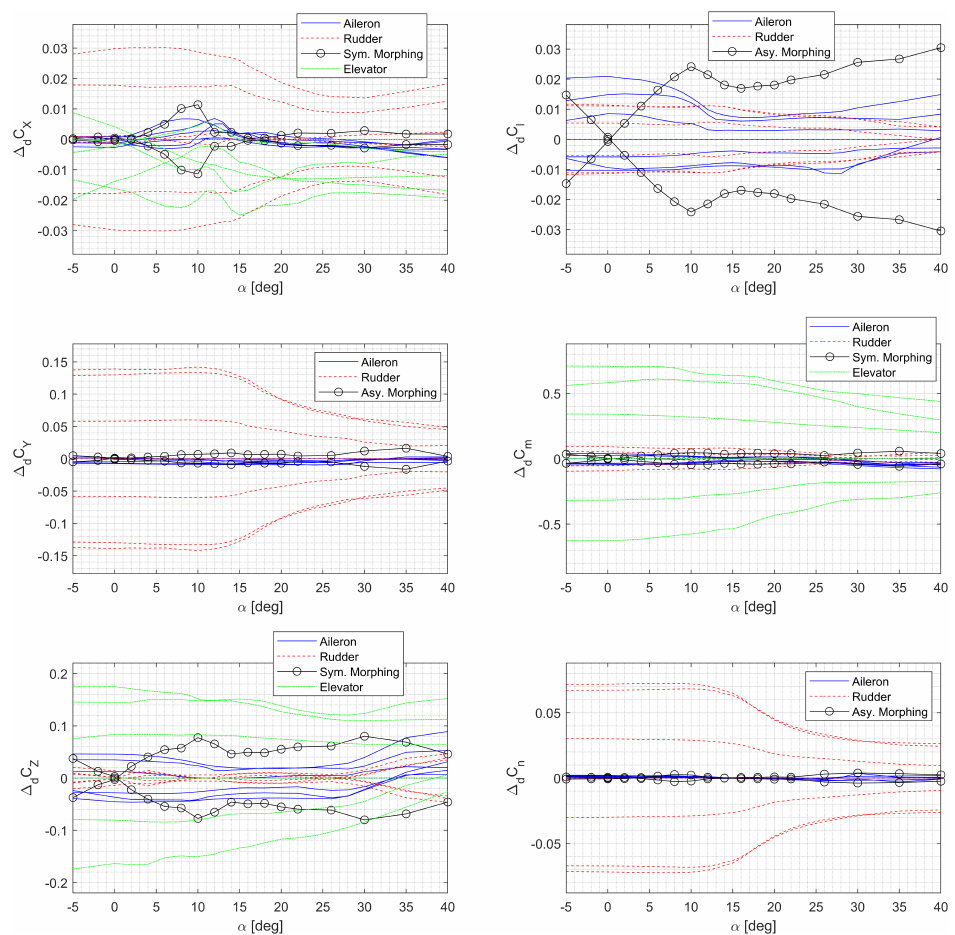
Figure 4. Control surface increment to the aerodynamic coefficients when β = 0